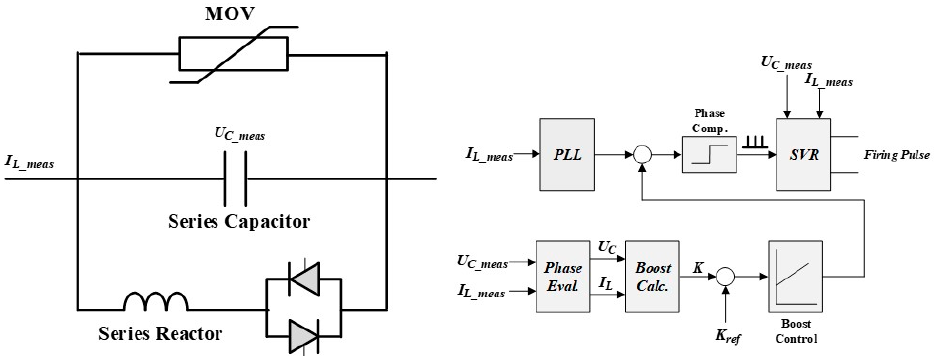
Figure 4. Thyristor Controlled Series Compensator (TCSC) topology and conceptual control block.